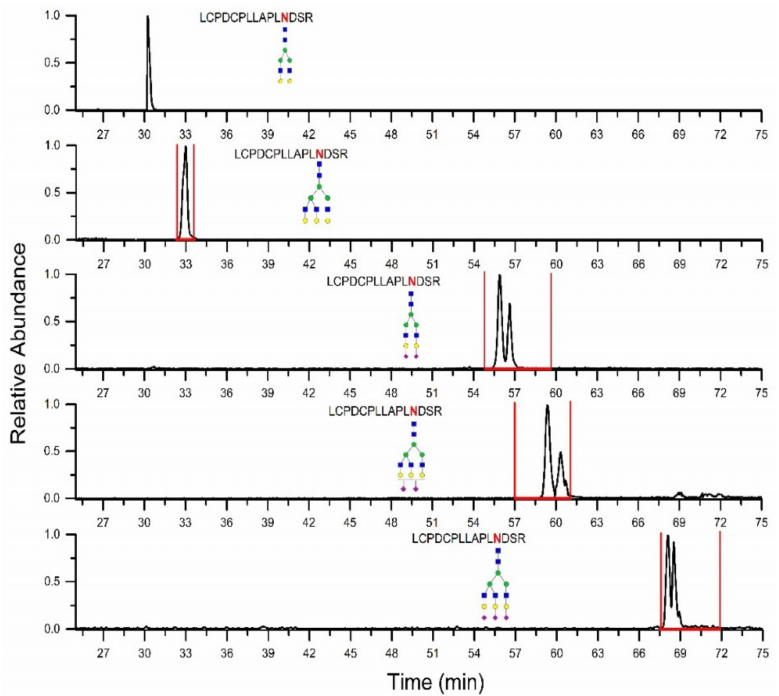
Figure 2. SRM chromatograms of selected fetuin LCPDCPLLAPLNDSR peptide glycoforms with retention time windows (marked by red lines) predicted according to the presented